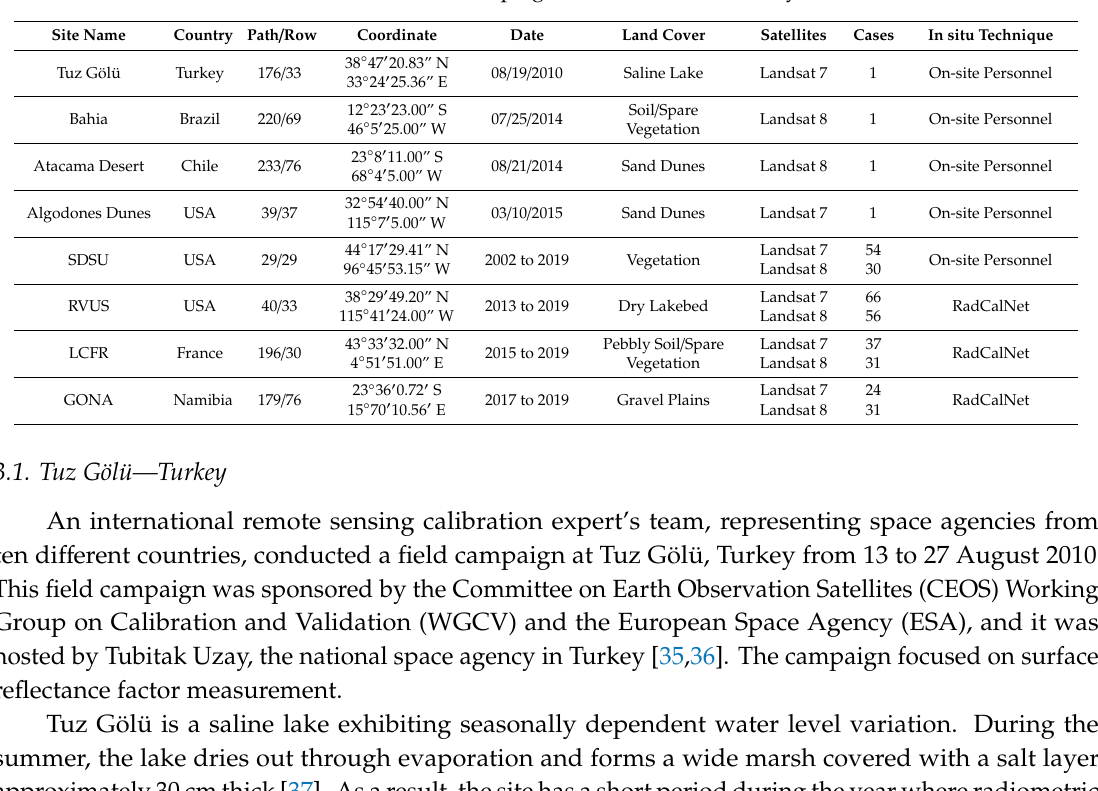
Table 1. Ground campaigns data used in this